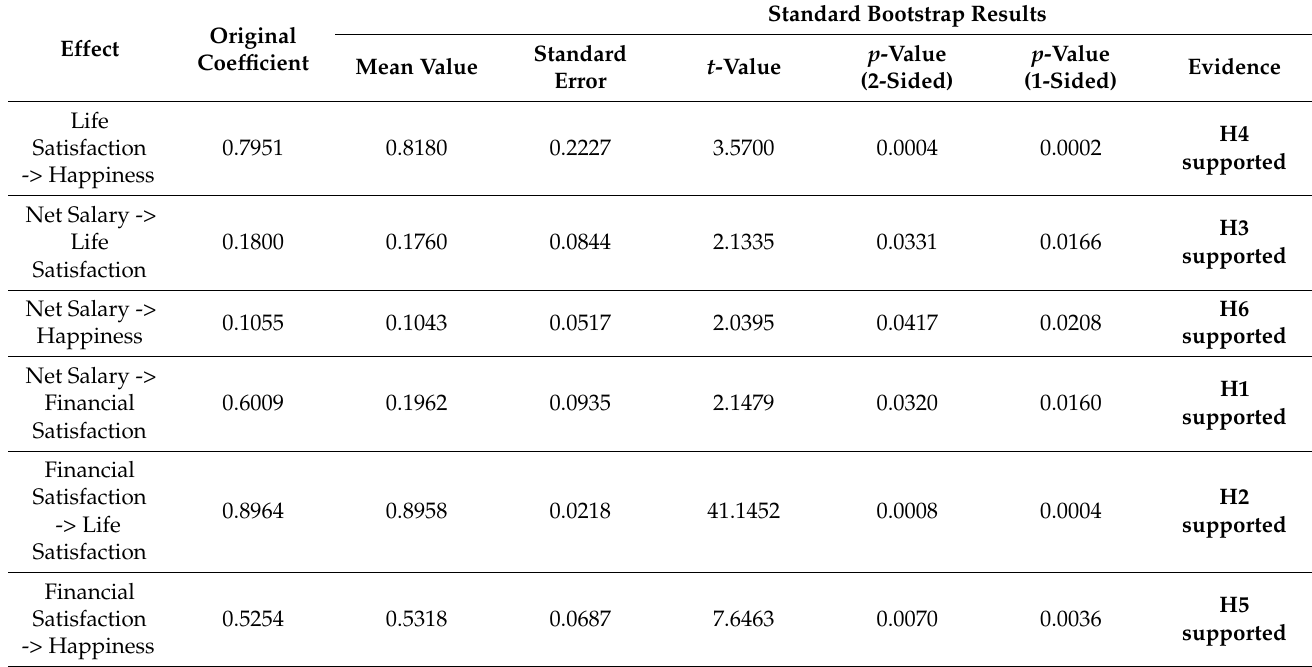
Table 4. Structural model results and hypotheses